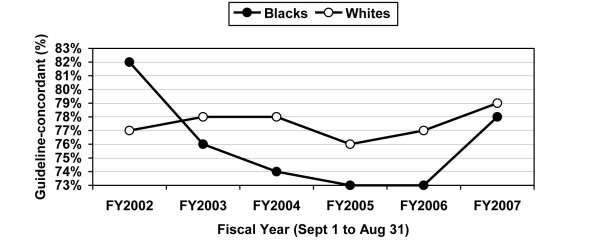
Annual guideline-concordant prescribing for African-American and Caucasian VHA patients with CAP admitted to the intensive care units (ICU patients)*. *The numbers in the figure represent the crude (unadjusted) guideline-concordant antibiotic prescribing rates.